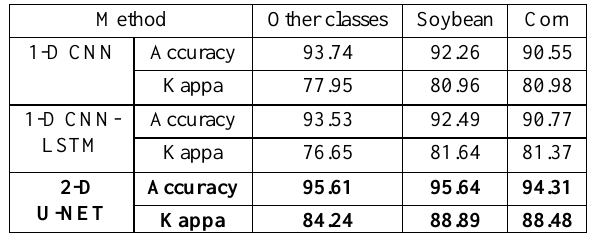
Table 3. The generated results by proposed